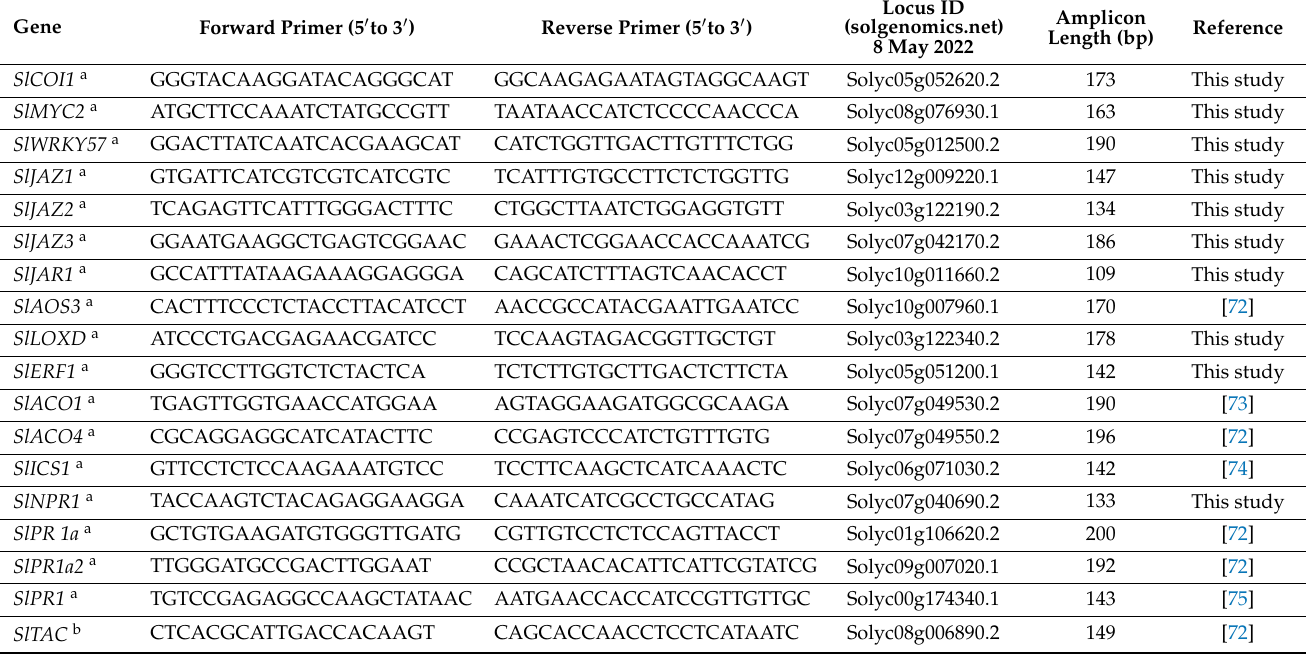
Table 1. List of primers used for gene expression analysis by quantitative real-time